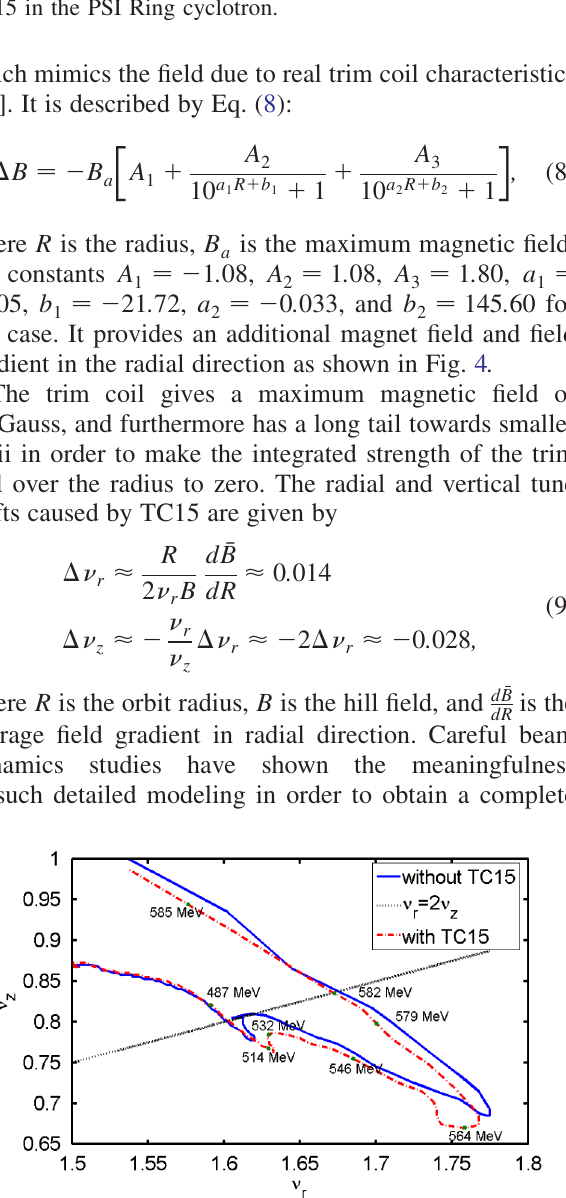
FIG. 4. The field (solid line) and field gradient (dashed line) of TC15 in the PSI Ring cyclotron.